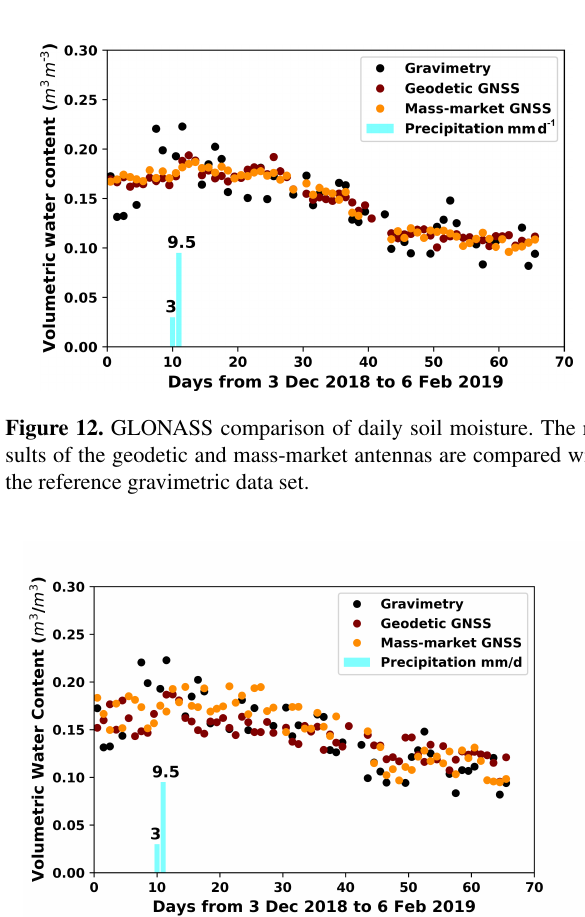
Figure 13. GALILEO comparison of daily soil moisture. The re- sults of the geodetic and mass-market antennas are compared with the reference gravimetric data